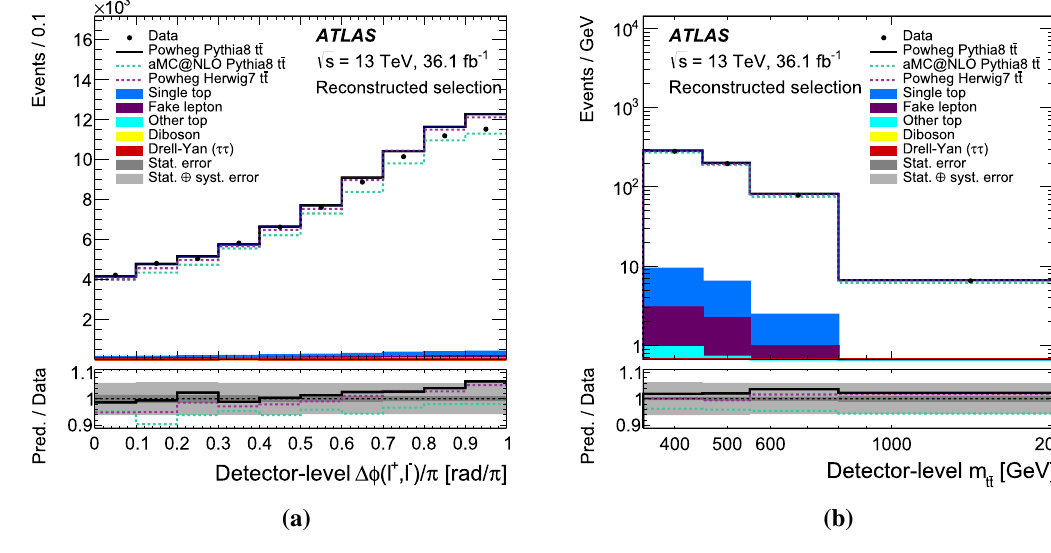
ing transverse momentum, background modelling, pile-up modelling and luminosity, but not PDF or signal t ¯ t modelling uncertainties. The observed distribution is compared to the sum of signal and background using three different t ¯ t signal models: Powheg + Pythia 8, Powheg + Herwig 7, and MadGraph5 _aMC@NLO + Pythia 8, and the ratio panel compares the summed prediction to data for the three